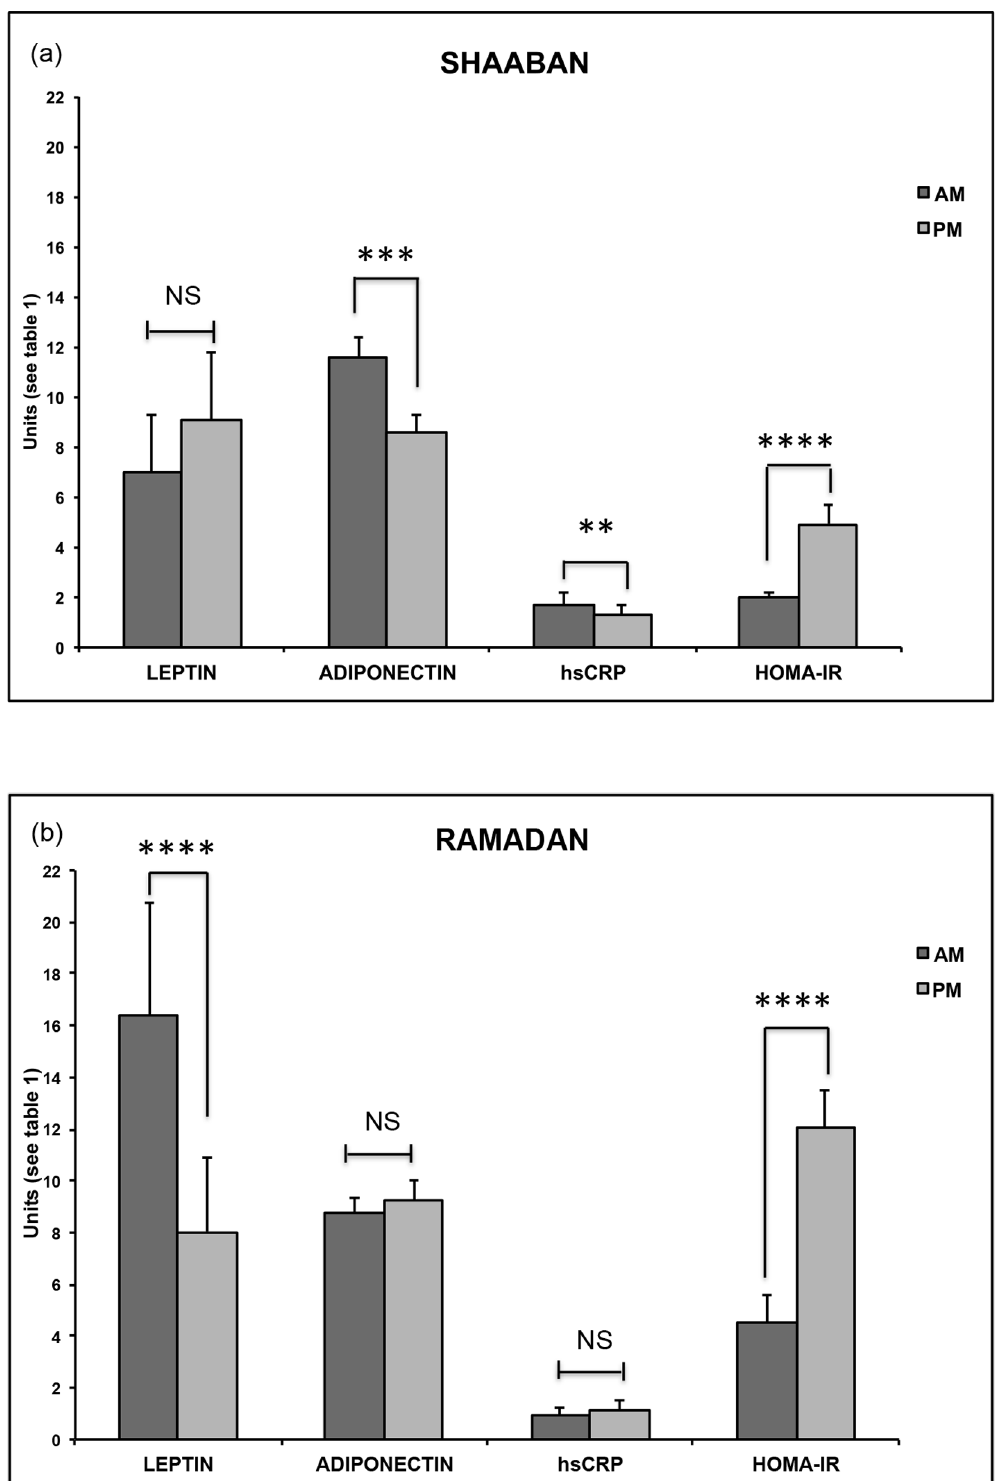
Figure 1. Circulating day and night levels of leptin, adiponectin, hsCRP and HOMA-IR during the Shaaban (a) and 2 weeks into the Ramadan (b) in 23 healthy young Saudi Arabians. **p , 0.01, ***p , 0.005, ****p , 0.0001.